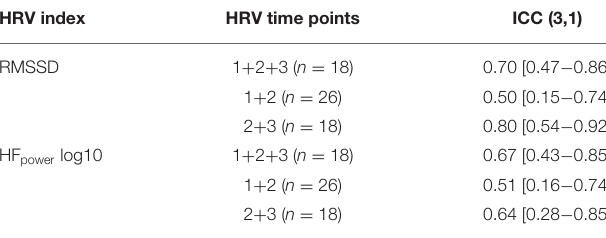
TABLE 2 | Intraclass correlations for HRV.